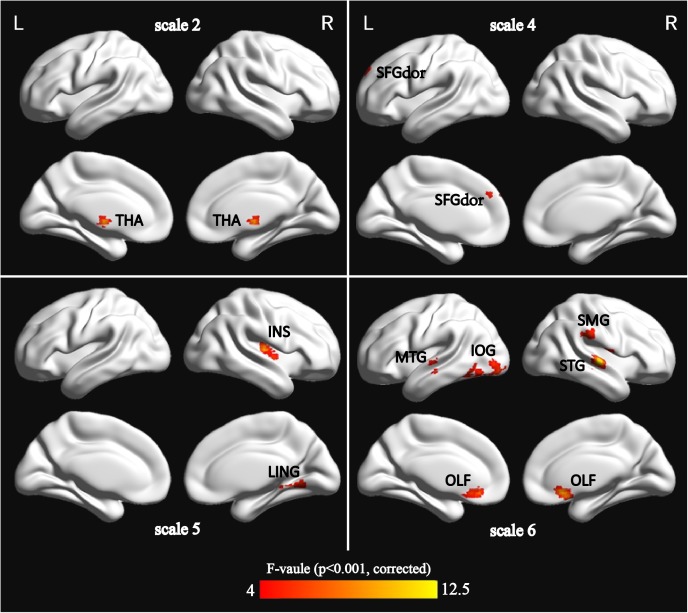
Surface-rendered images showed the differences between the control and patient groups after adjusting for age, sex, and education. The regions showed significantly different brain regions among the four groups on scale 2, scale 4, scale 5, and scale 6. See Table 2 for a complete list of these regions (threshold p < 0.001, GRF corrected).